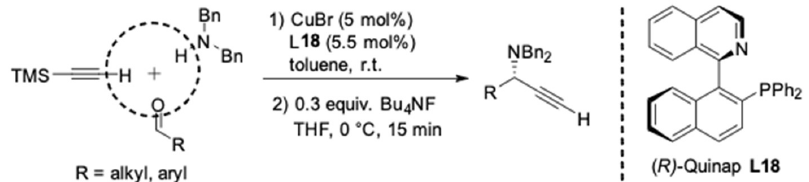
Figure 14 . Asymmetric A 3 -couplings and desilylation to terminal alkynes. Figure 14. Asymmetric A 3 -couplings and desilylation to terminal alkynes.